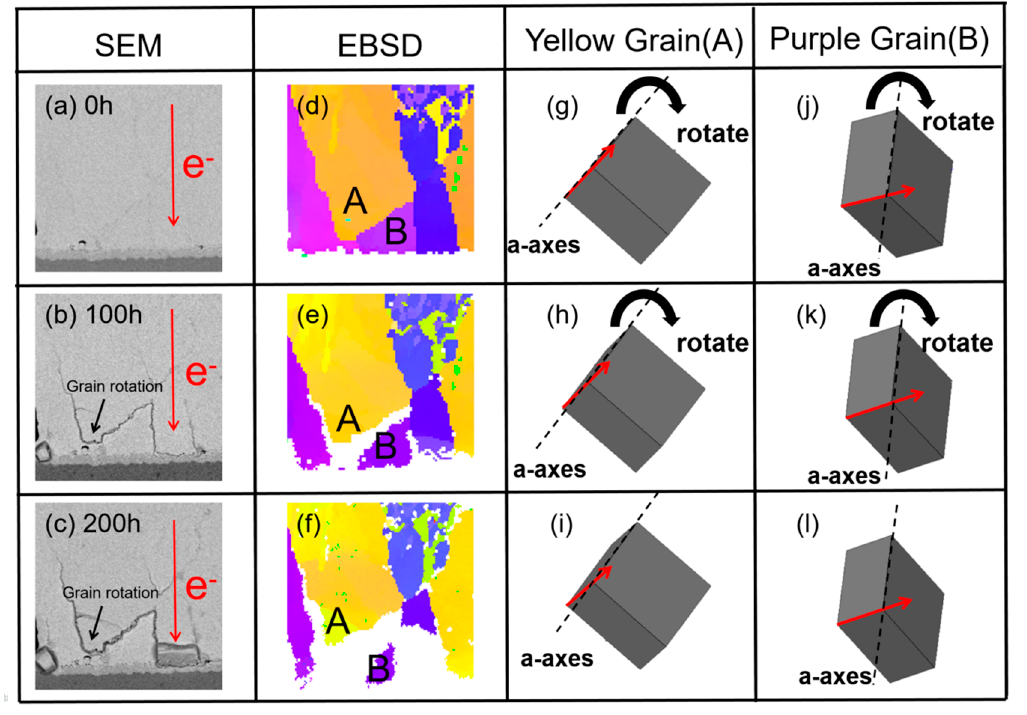
Figure 2. The cross-section of a grain rotation area that was stressed with a current density of 1.6 × 10 4 A / cm 2 at 25 ◦ C for di ff erent times: ( a ) SEM image for 0 h; ( b ) SEM image for 100 h; ( c ) SEM image for 200 h; ( d ) corresponding electron backscattered di ff raction (EBSD) image of ( a ); ( e ) corresponding EBSD image of ( b ); ( f ) corresponding EBSD image of ( c ); ( g – i ) the unit cells of yellow grain correspond to ( d – f ); ( j – l ) the unit cells of purple grain correspond to ( d – f ).